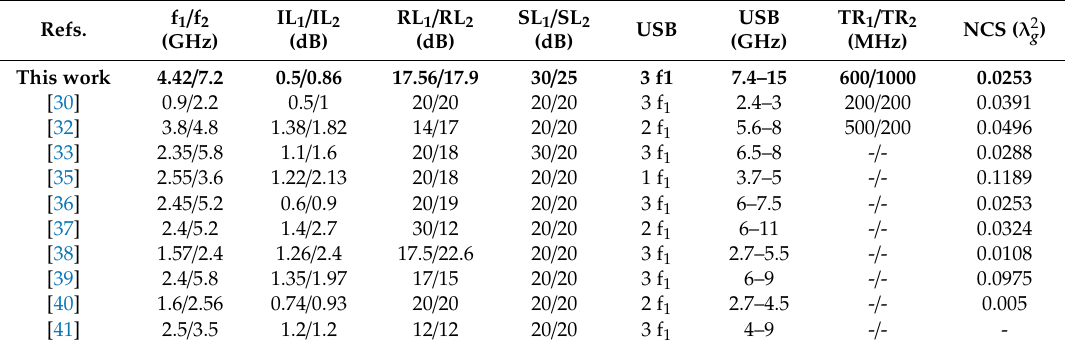
Table 1. Characteristics of proposed work and some